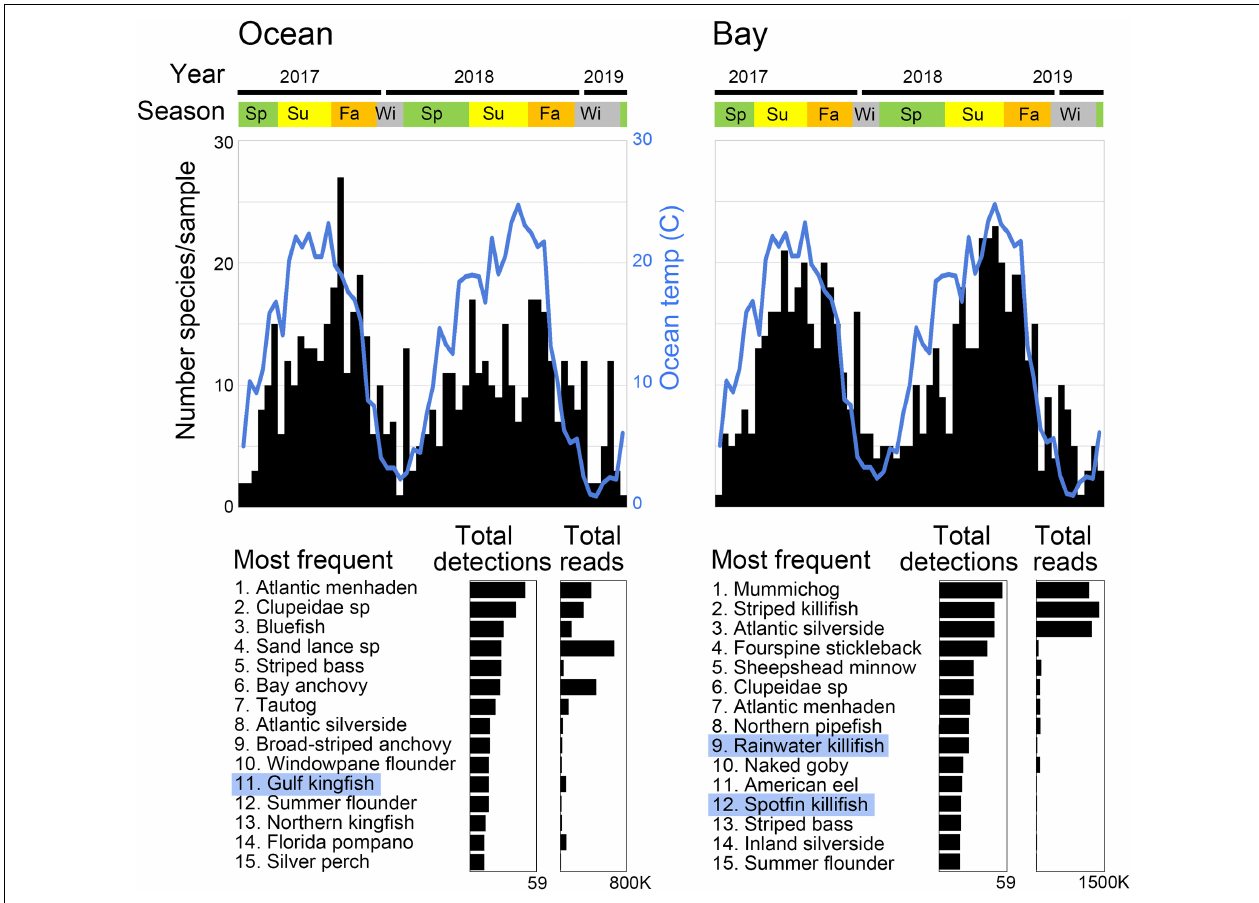
FIGURE 3 | Two-year time series of bony fish eDNA in coastal New Jersey. Fishes with new reference sequences reported in this study are highlighted in